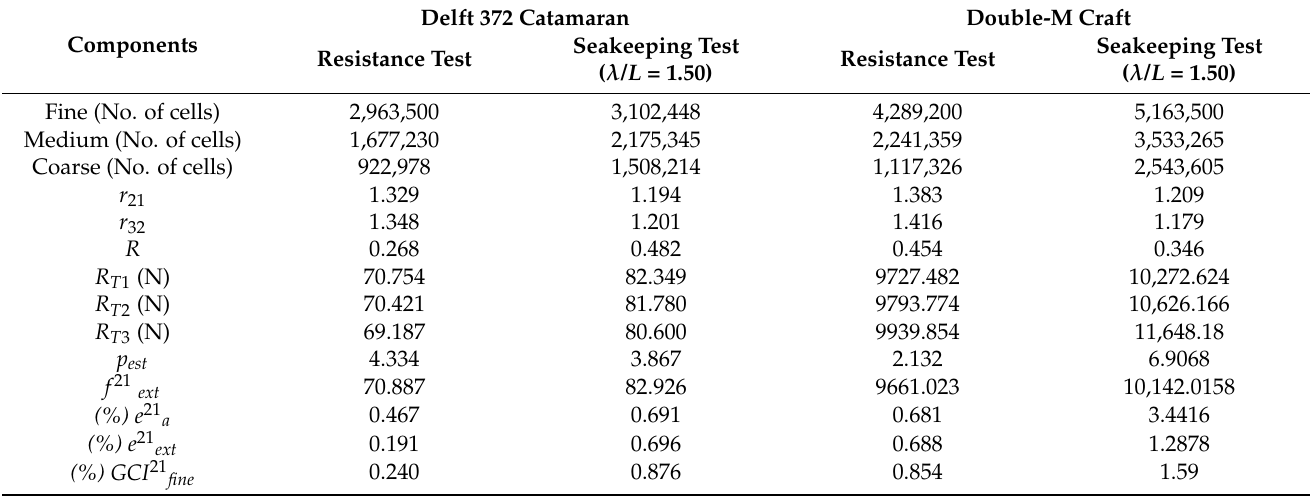
Table 6. Discretization error components of the spatial convergence study for Delft 372 catamaran and Double-M craft at Fr = 0.7. Delft 372 Catamaran Double-M Craft Components Seakeeping Test Seakeeping Test Resistance Test Resistance Test ( λ /L = 1.50) ( λ /L =